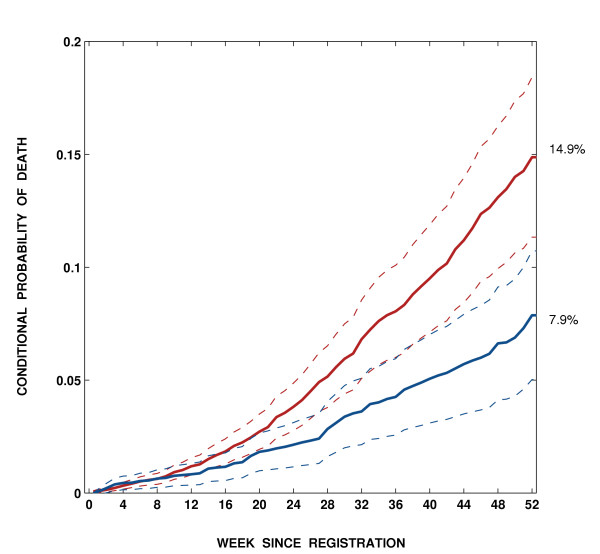
Estimated conditional probability for all-cause death and 95% confidence intervals, by week since registration in high-severity (red) and low-severity groups (blue); two-sample test = 3.1, p = 0.002.